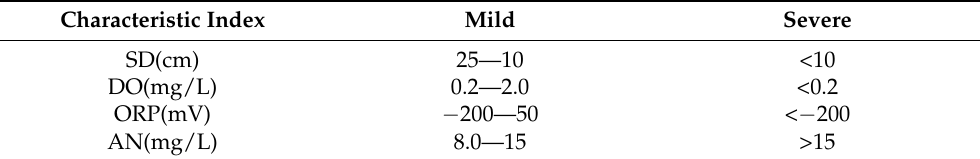
Table 2. Classification standard of the pollution levels of urban black-odor